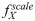
Emergence of ‘adder’ size homeostasis and cellular individuality in the presence of reaction noise.(A) Simulation of model dynamics with molecular noise (top: total cell size, bottom: concentrations of cellular components). At division, cellular components are randomly split between daughter cells, so the tracked daughter has a probability 1/2 of getting each mother cell component. Same parameters as in Fig 2A. The parameters Xdiv and fXscale were chosen to obtain realistic cell-to-cell variability in size at birth and growth rate (Methods). (B) Model leads to near 'adder' size homeostasis. Average added size during one cell cycle as a function of birth cell size (via binning) is plotted. The very weak deviation towards ‘sizer’ can be explained by a residual correlation between size at birth and X count at birth due to the non-zero share of X in total size. A model variant where X is actively degraded at a constant rate and displaying a stronger deviation towards 'sizer' behavior is also shown. Other model variants exploring size homeostasis properties are discussed in Fig G in S1 Text. (C) Emergence of cellular individuality. Stochastic stimulations are performed for ten different growth conditions: seven nutrient qualities (green triangle groups), two useless expression strengths (red triangle groups) and one chloramphenicol (blue triangle groups). For each condition, cell cycles are binned by growth rate and the corresponding birth size is plotted. Continuous lines show the prediction of the deterministic model for the three growth rate modulations. Grey lines indicate experimental trends for different nutrient qualities extracted from mother machine data (Taheri-Araghi et al., 2015).